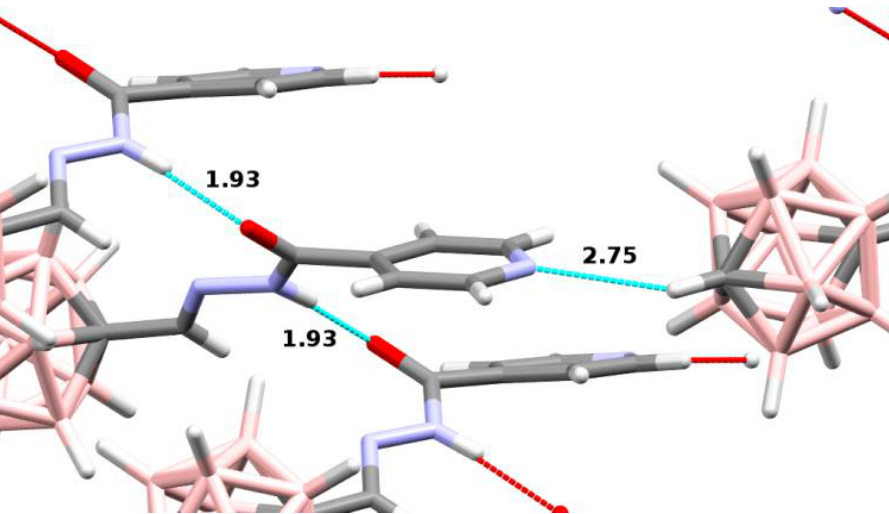
Figure 5. Intermolecular interactions in the crystal structure of 15 . Hydrogen bonds are indicated by dotted lines, and distances are in Å. Some molecules are hidden for clarity.